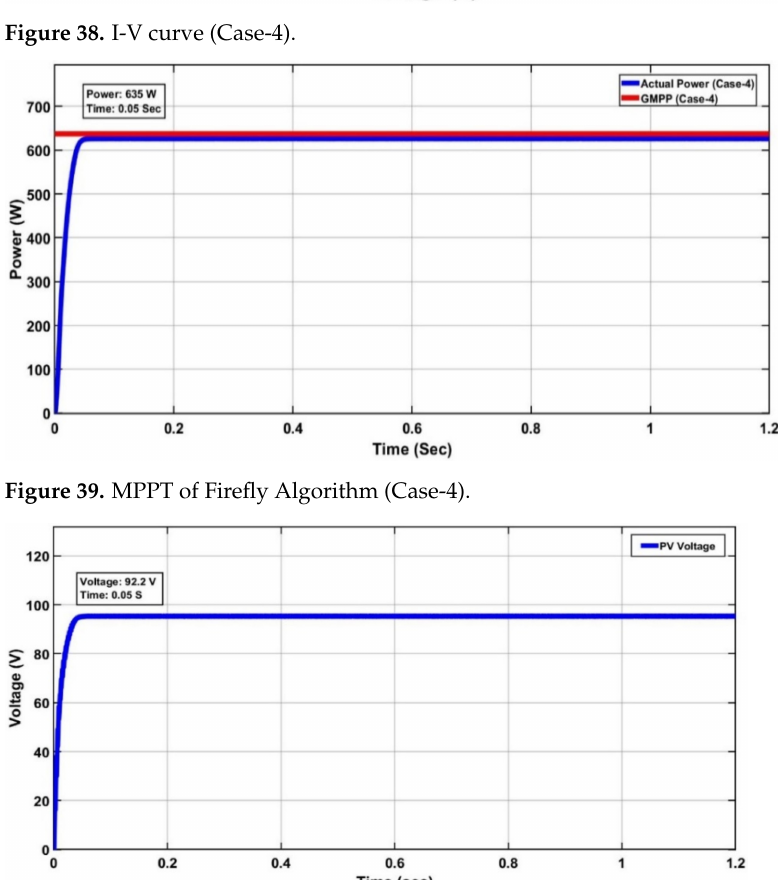
Figure 38. I-V curve (Case-4).